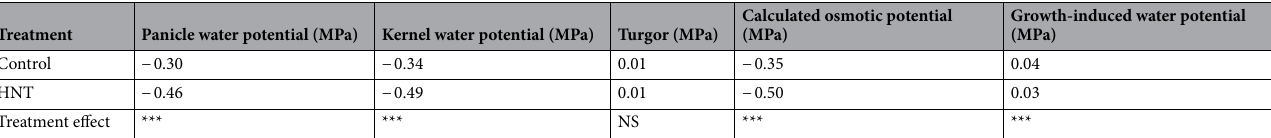
Table 2. Panicle water potential, kernel water potential, endosperm cell turgor, calculated osmotic potential, and growth-induced water potential determined at 8 DAH nighttime in control and HNT treatment. Kernel water potential was calculated by regression equation (see “Results” section). Cell turgor was directly determined at 9 DAH. The calculated osmotic potential was calculated by subtracting turgor from kernel water potential. The growth-induced water potential was calculated by subtracting the kernel water potential from panicle water potential (source of water). The data of panicle and kernel water potential are means ± SE from 6 to 9 independent plants in each treatment. The data of turgor are means ± SE from 12 to 15 cells from 5 to 8 kernels from three independent plants in each treatment *** and NS indicate p < 0.001 ( t -test) and no significant difference,